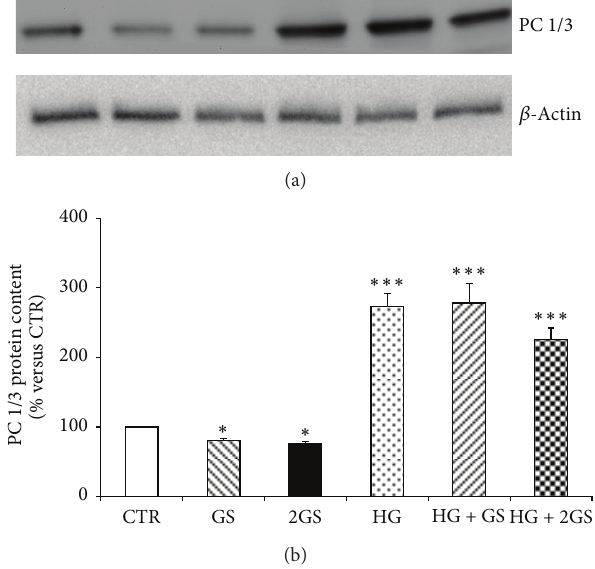
Figure 4: HG increases PC 1/3 protein levels, while GS decreases them. (a) Representative western blot analysis. (b) Quantification of densitometries of western blot bands. Data were expressed as mean ± SE of fold induction relative to 𝛽 -actin ( 𝑛 = 3 ). ∗ 𝑃 < 0.05 and ∗∗∗ 𝑃 < 0.001 versus